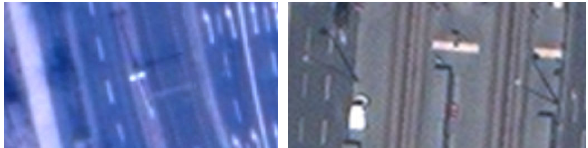
Figure 3. Sections 40 × 20 m 2 , left: poor example (Hamburger Straße, Braunschweig, WorldView-4, 2018-03-30, GSD 30 cm), right: good example (Karlsplatz (Stachus), München, WorldView-3, 2019-07-04, GSD 30 cm), both c (cid:13) European Space Imaging, 2018/2019